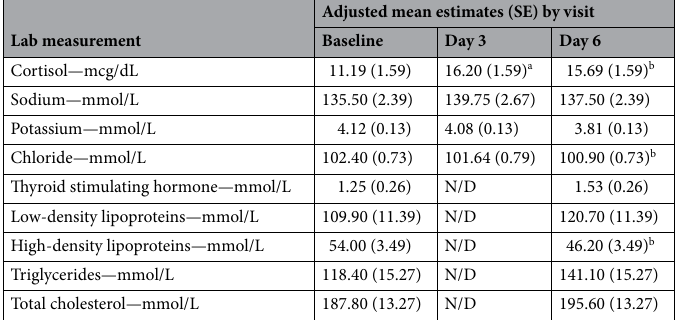
Table 4. PT150 effects on lab measurements. N/D not determined. a Lab value collected on day 3 statistically different from the lab value collected on baseline based on p ≤ 0.05. b Lab value collected on day 6 statistically different from the lab value collected on baseline based on p ≤